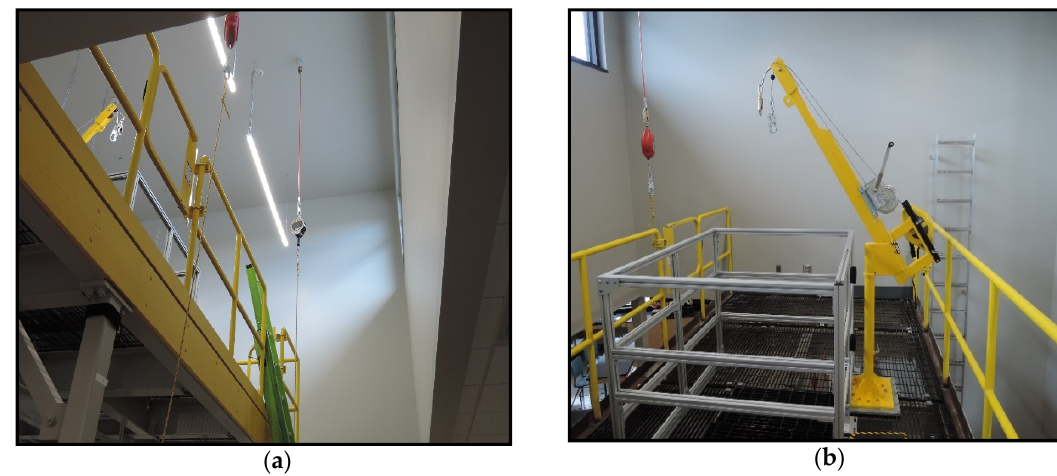
Figure 2. Personal fall arrest anchorages: ( a ) ceiling mounted anchor, ( b ) davit on the mezzanine.